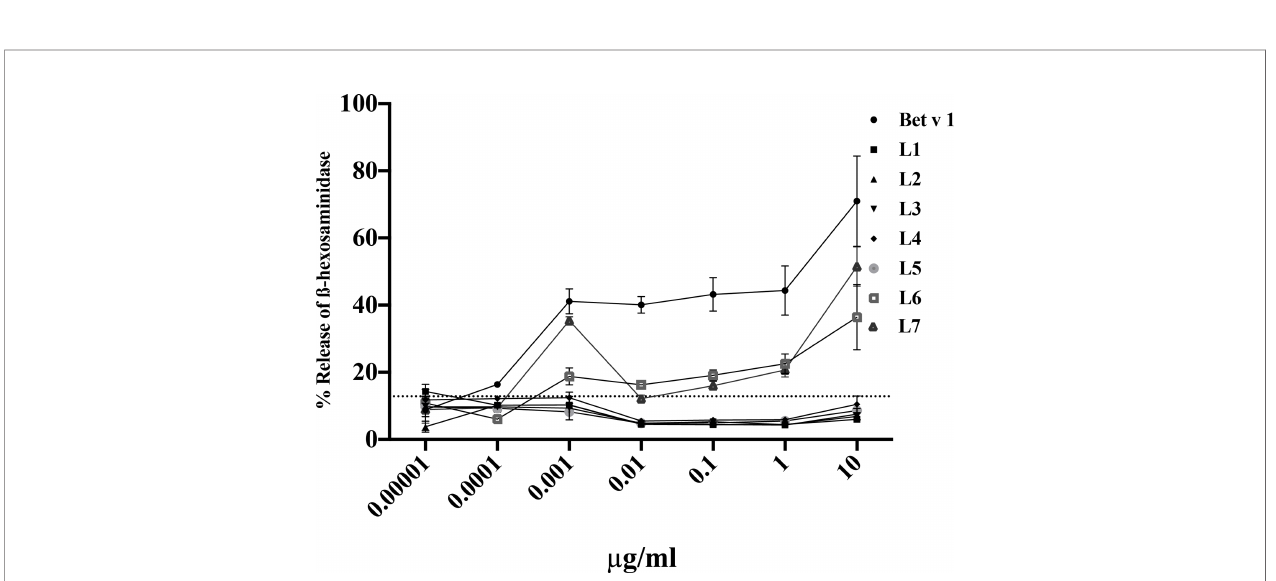
FIGURE 6 | Basophil activation responses with sera from Bet v 1 sensitized mice upon incubation with Bet v 1 and Bet v 1-derived peptides. RBL-2H3 cells were incubated with pooled sera from Bet v 1-sensitised mice (n=10) and degranulation was determined in response to different concentrations (0.00001µg/ml – 10µg/ml) of Bet v 1 or Bet v 1 peptides (L1-L7) ( x-axes ). The releases are shown as mean percentages and standard deviations of total b -hexosaminidase release for triplicate determinations (y-axes). The control measurements with pre-immune sera reveal an upper 2-sigma limit value of 12.83%. All means above this line are signi fi cantly different from control